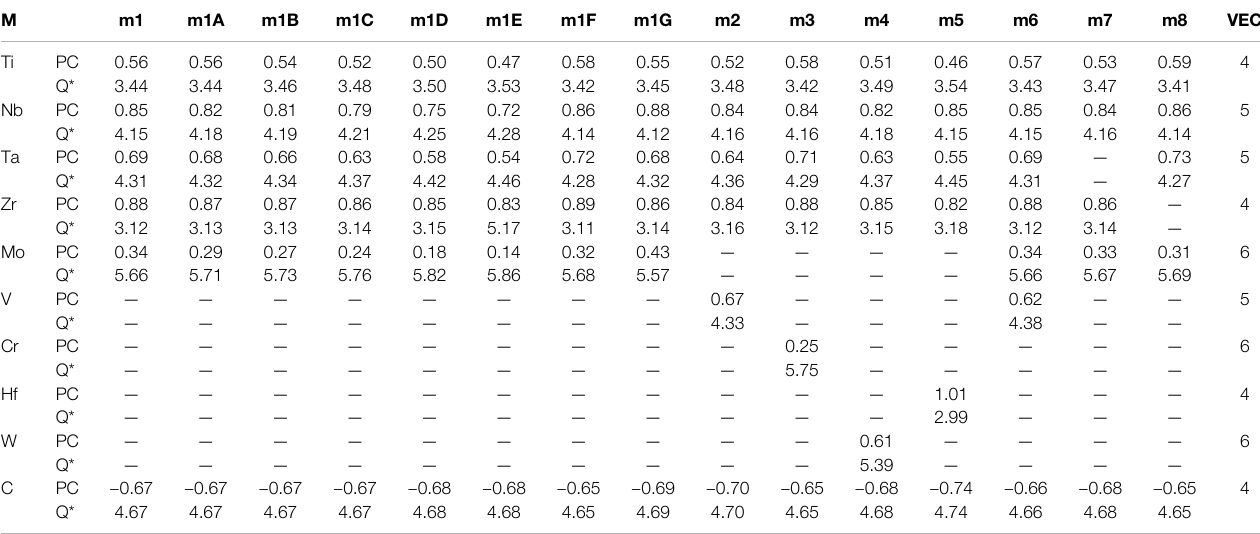
TABLE 3 | Partial charge (PC) and effective charge (Q*) for each atom (in electrons) in the 15investigated HEA models and in comparison with the standard valence electron count